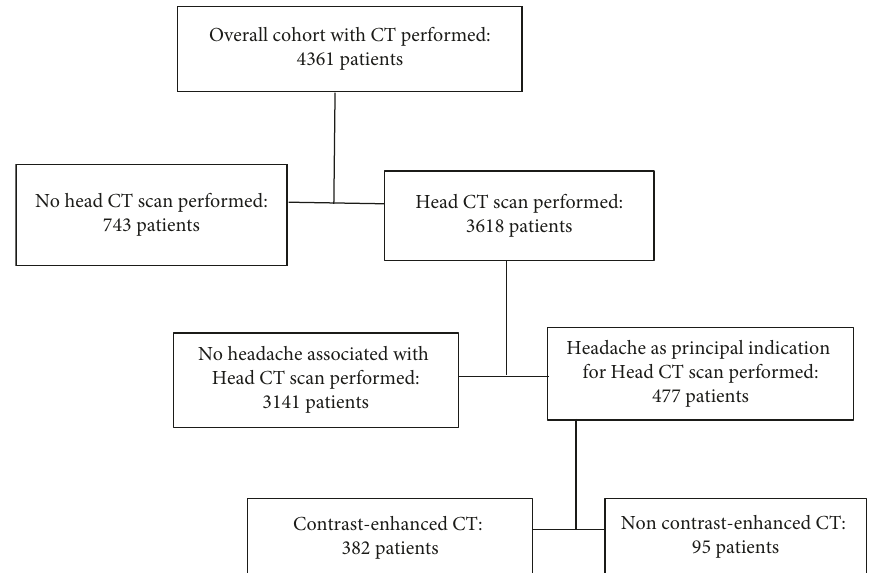
Figure 1: Flowchart of performed head CT scans in contrast medium in patients with any type of headache. Table 1: Patients characteristic of contrast CT and noncontrast CT head examinations, 2017–2020.